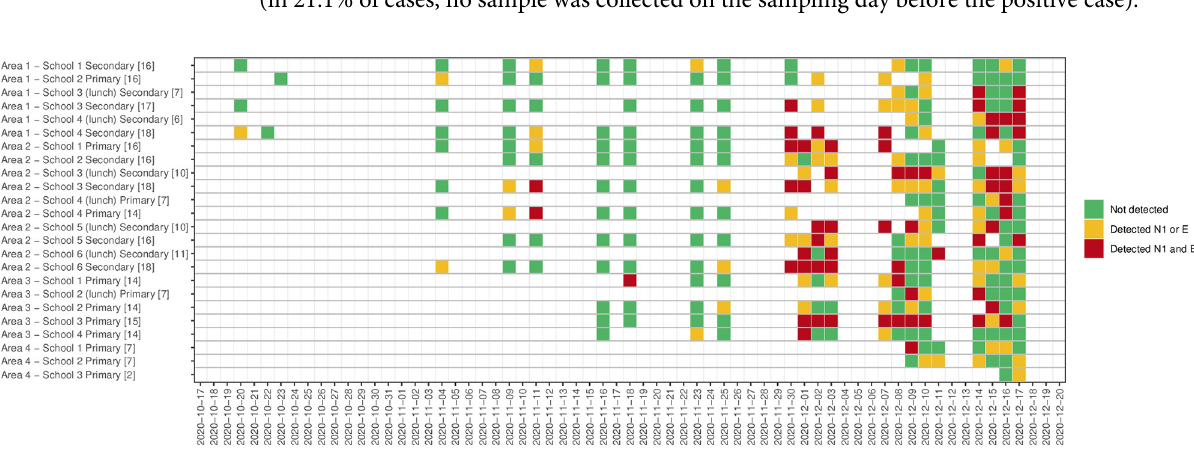
PLOS ONE | https://doi.org/10.1371/journal.pone.0270168 June 17,